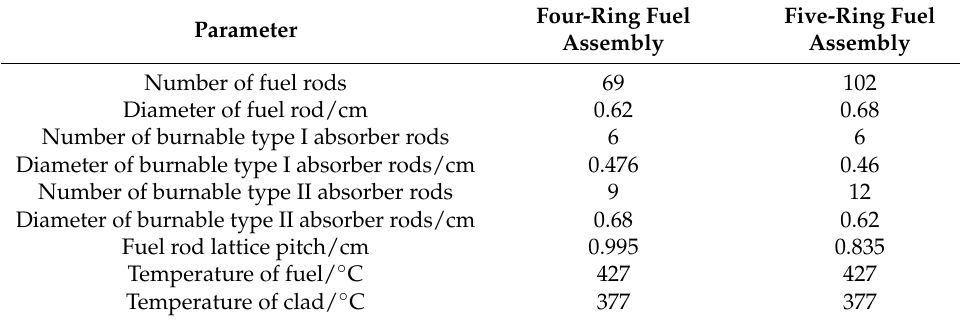
Table 3. Parameters of fuel